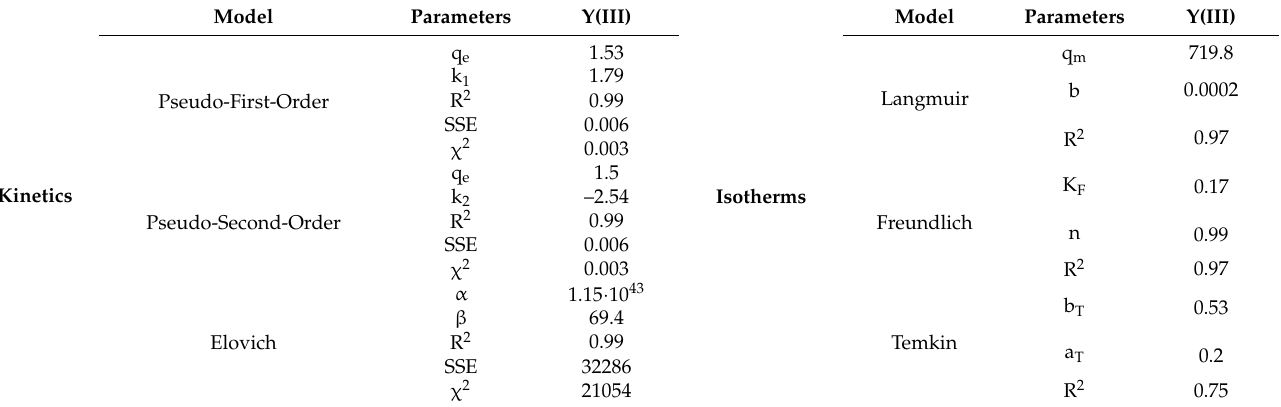
Table 1. Parameters of the kinetics and isotherm of Y(III) sorption on A. platensis